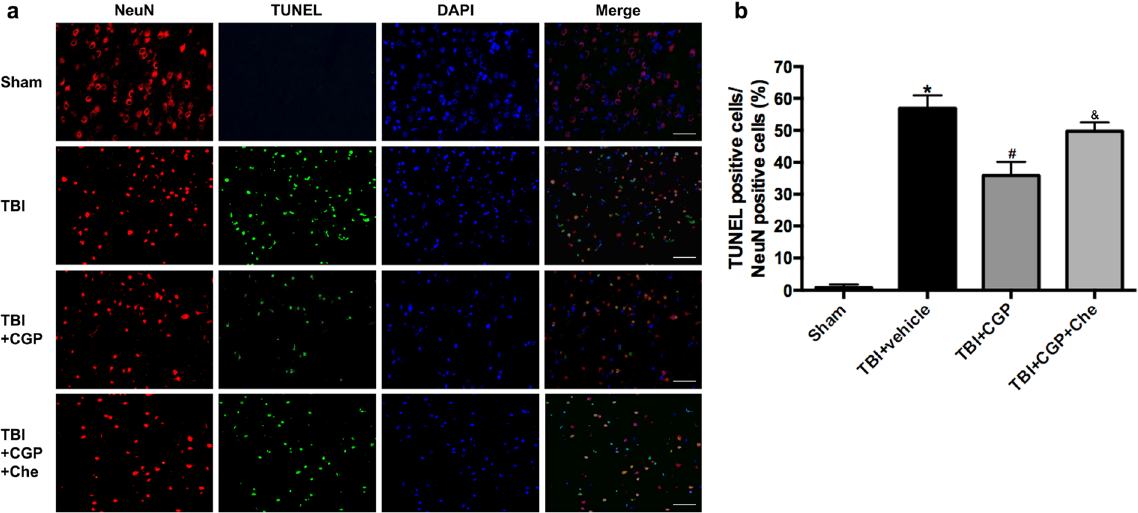
Figure 5. Effects of CGP3466B on cell apoptosis in the peri-injured cortex at 24 h after TBI. ( a ) Representative TUNEL/NeuN/DAPI photomicrographs of the peri-injured cortex in different groups. Fluorescence colors: TUNEL-green, NeuN-red and DAPI-blue. Scale bar = 50 μ m. ( b ) Quantification of TUNEL-positive neurons in different groups, expressed as percentage of total neurons (NeuN + ). Data are represented as the mean ± SD, n = 6 rats per group. * P < 0.05 vs sham, # P < 0.05 vs TBI + vehicle, & P < 0.05 vs TBI +